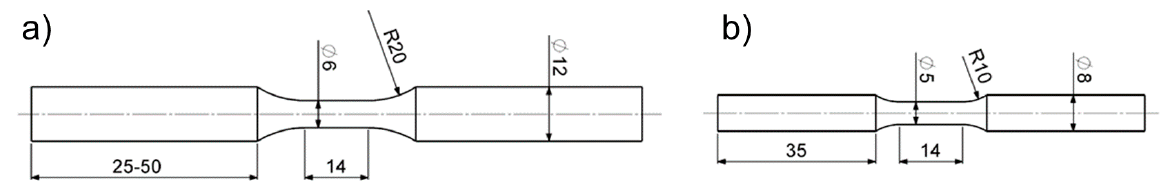
Figure 2. Specimen geometry for fatigue tests of CG ( a ) and UFG ( b ) material conditions. All dimensions are in mm.